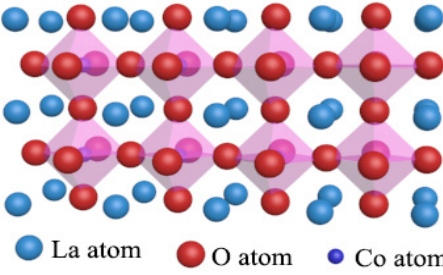
Figure 1. Structure of LaCoO 3.